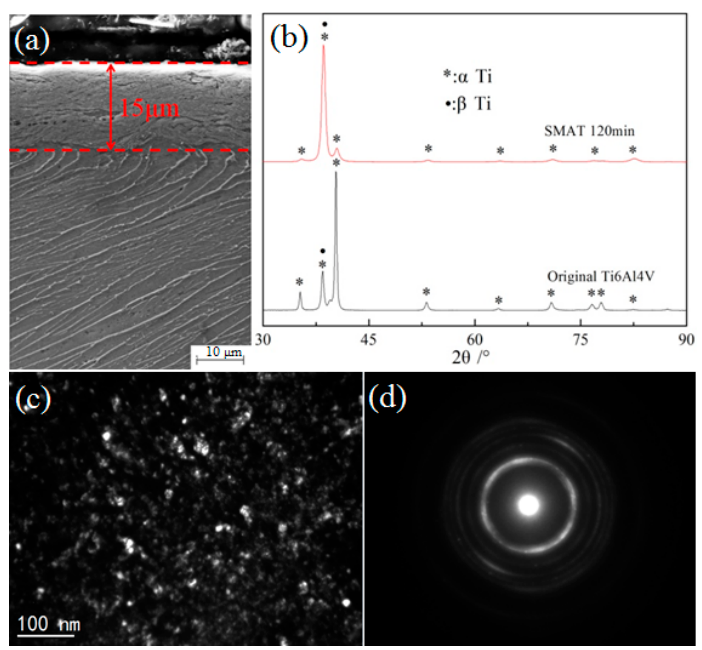
Figure 1. The microstructure characterizations of the SMAT Ti-6Al-4V alloy: ( a ) SEM micrographs; ( b ) XRD patterns; ( c ) TEM image (dark field); ( d ) SAED pattern.